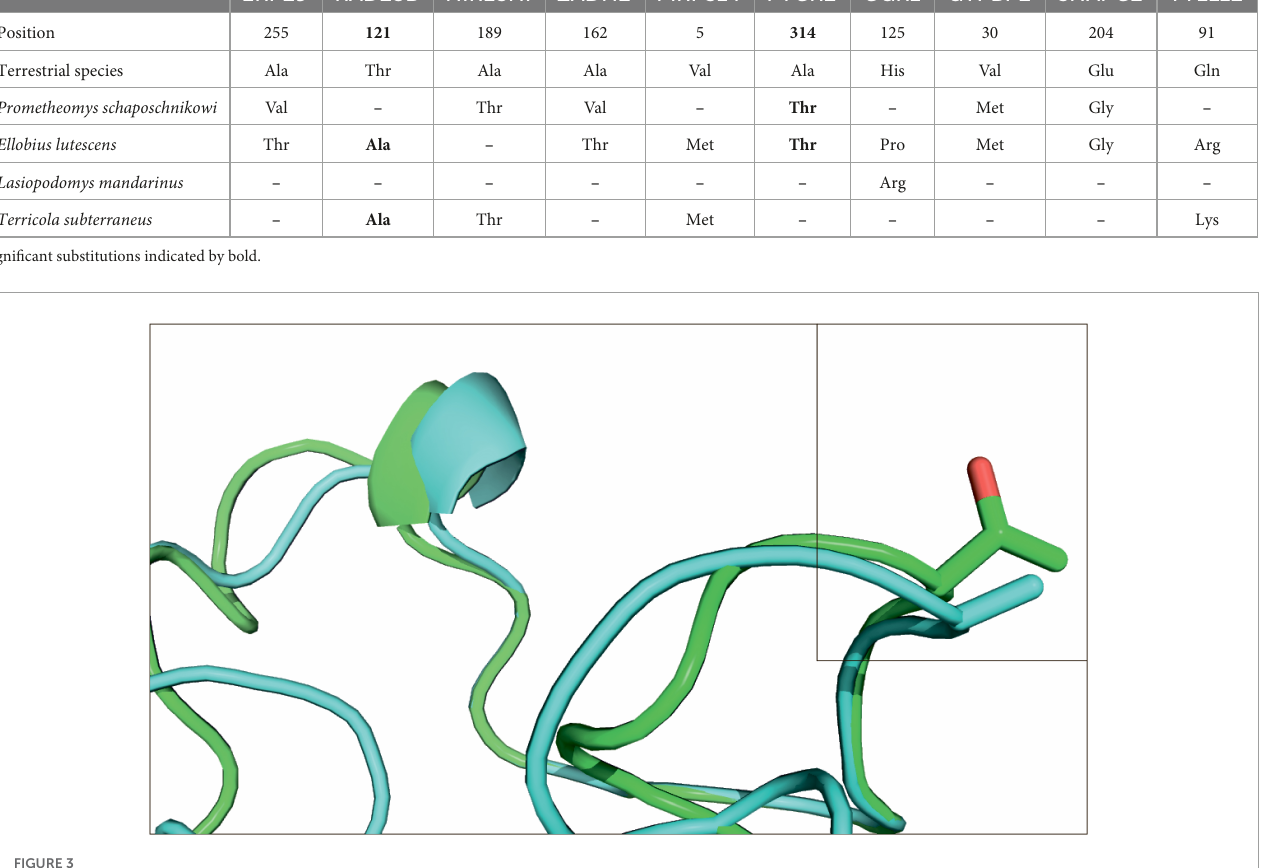
FIGURE3 Structural model of substitutions in the RAD23 gene. E. lutescens (subterranean) model is green, L. gregalis Pallas, 1779 (terrestrial) is cyan. Position 143 is framed.